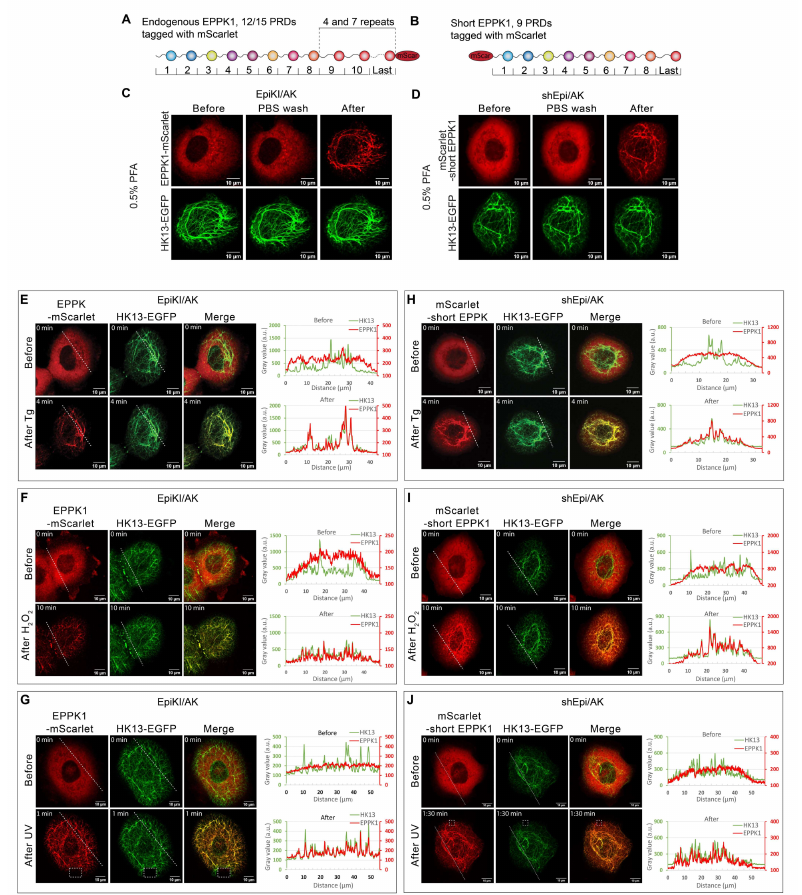
Figure 1. EPPK1 is diffusely distributed in the cytoplasm of living A-431-derived cells and rapidly associates with keratin filaments during fixation with PFA and after stress induction. ( A , B )